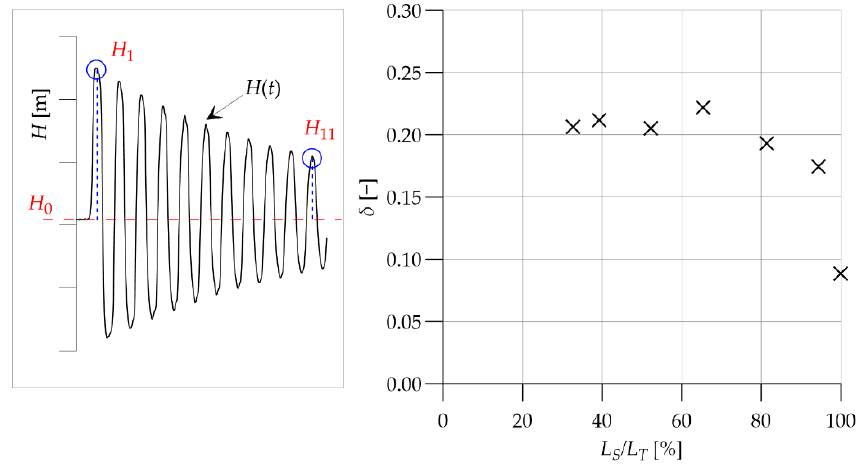
Figure 7. Values of logarithmic damping decrement as a function of L S / L T